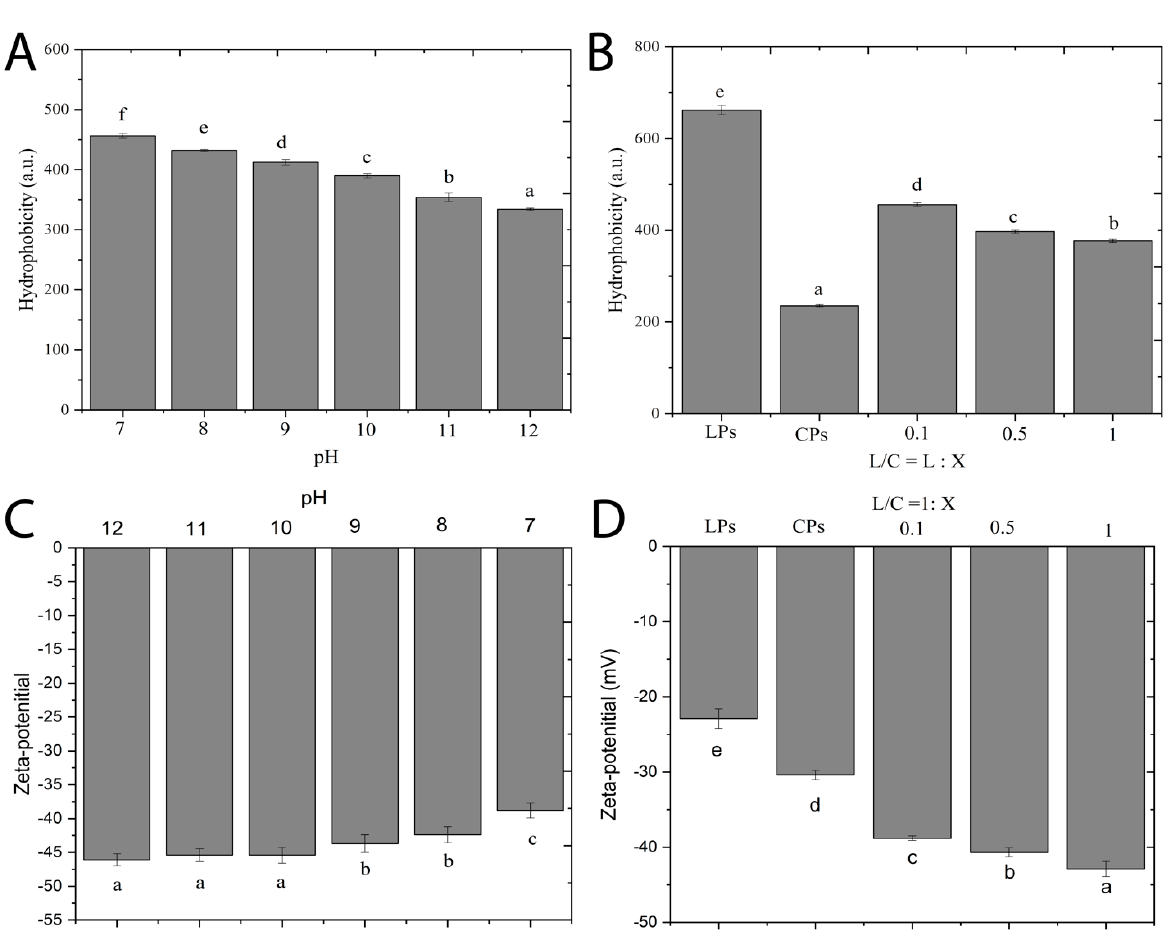
Figure 5. Surface characteristics of lentil proteins (LP) and lentil-casein protein complexes (LCPC). ( A ) Surface hydrophobicity ( H o ) of LCPC 1.0:0.1 at a range of pH 7 to 12. ( B ) H o of LP, CP, and LCPC at pH 7. ( C ) Zeta potential of LPCP 1.0:0.1 at a range of pH 7 to 12. ( D ) Zeta potential of LP, CP, and LCPC at various LP:CP ratios. Different letters indicate statistically significant differences ( p < 0.05).